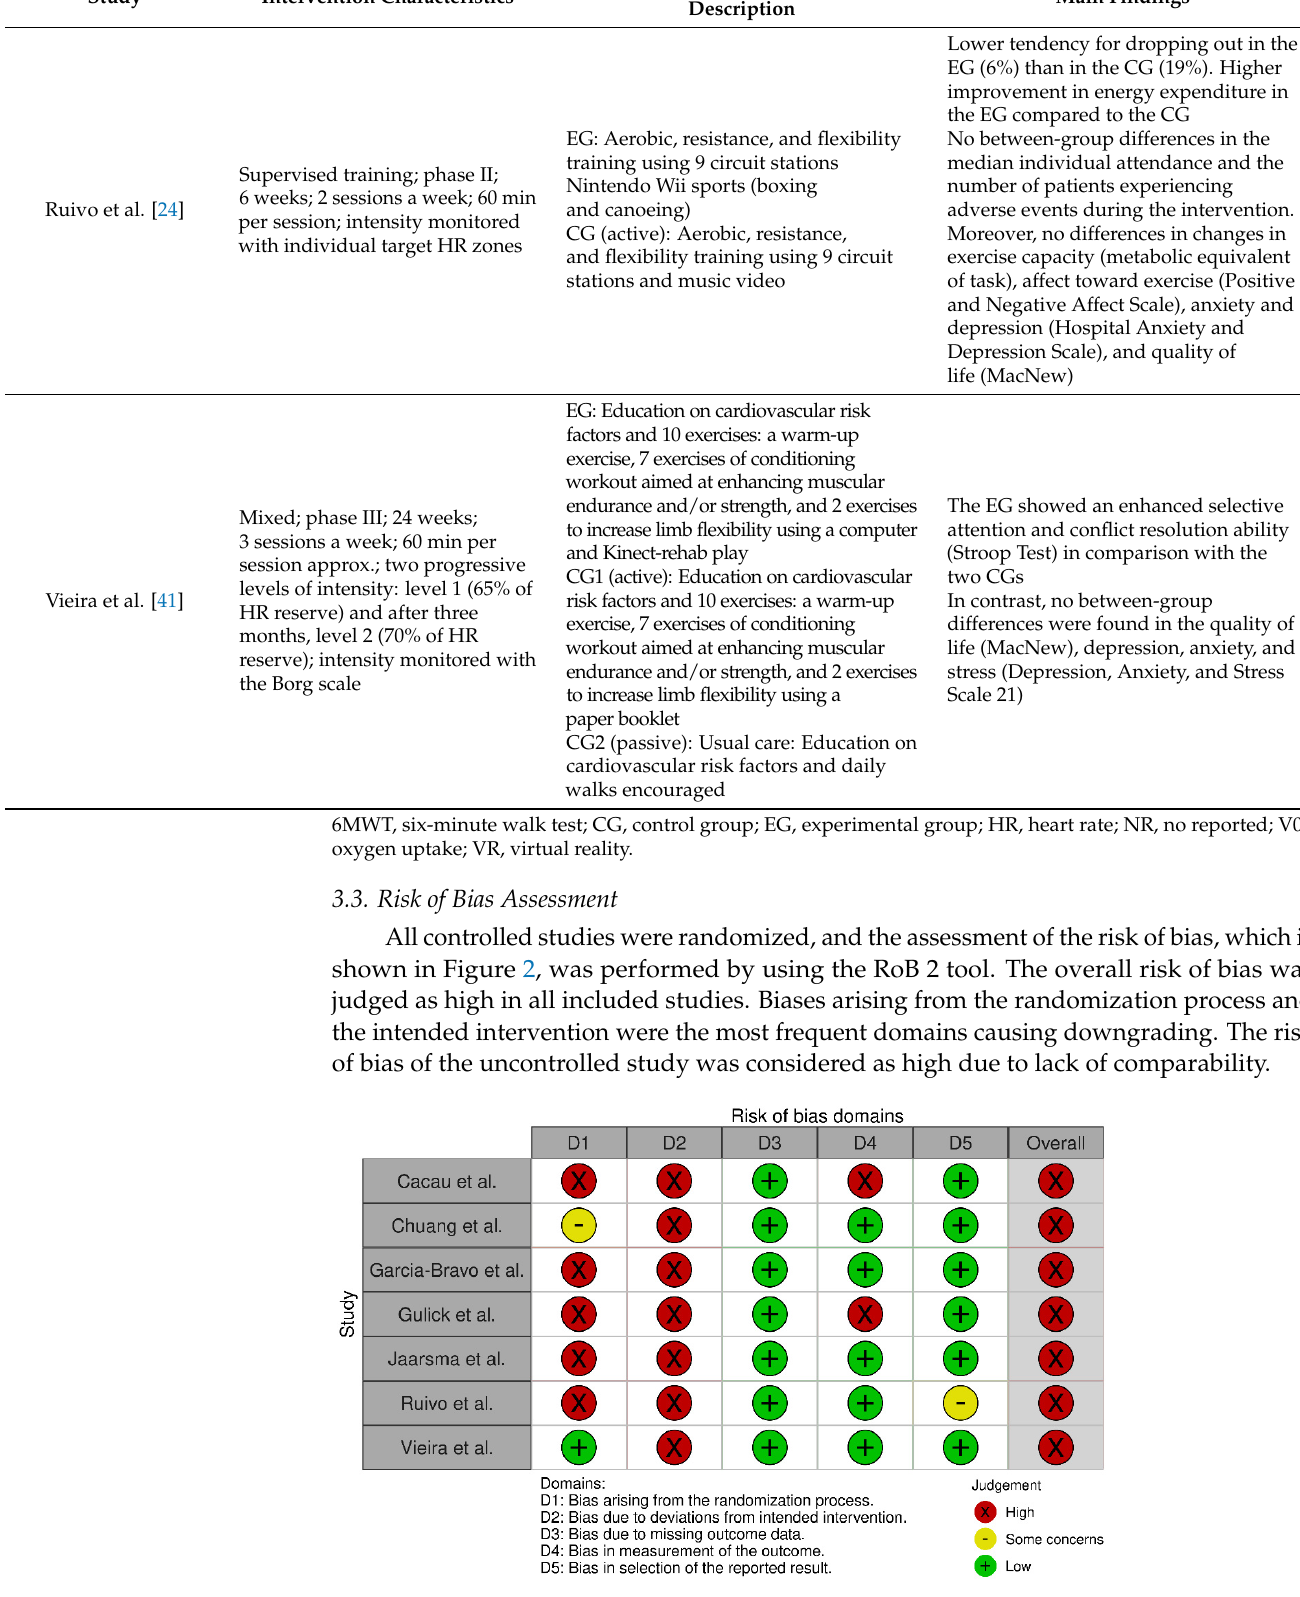
Figure 2. Risk of bias of the controlled studies rated using RoB 2